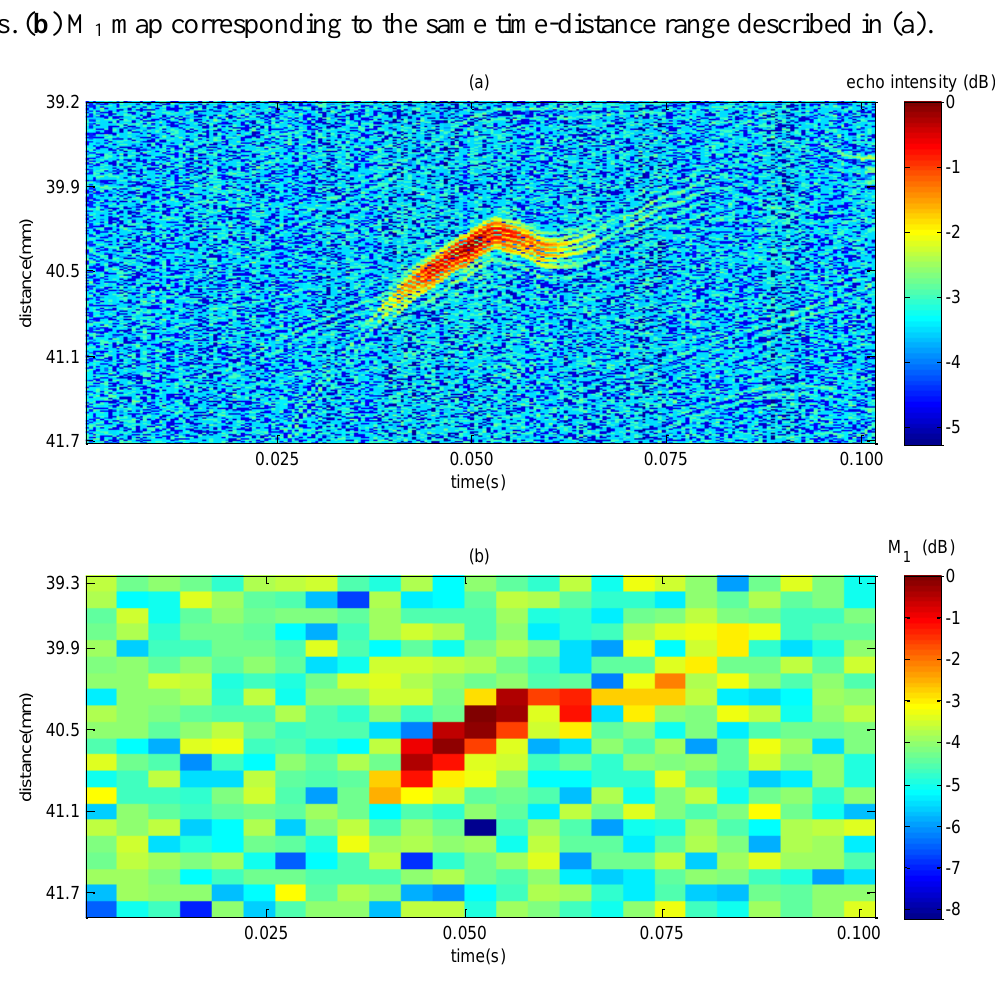
and with echo 1